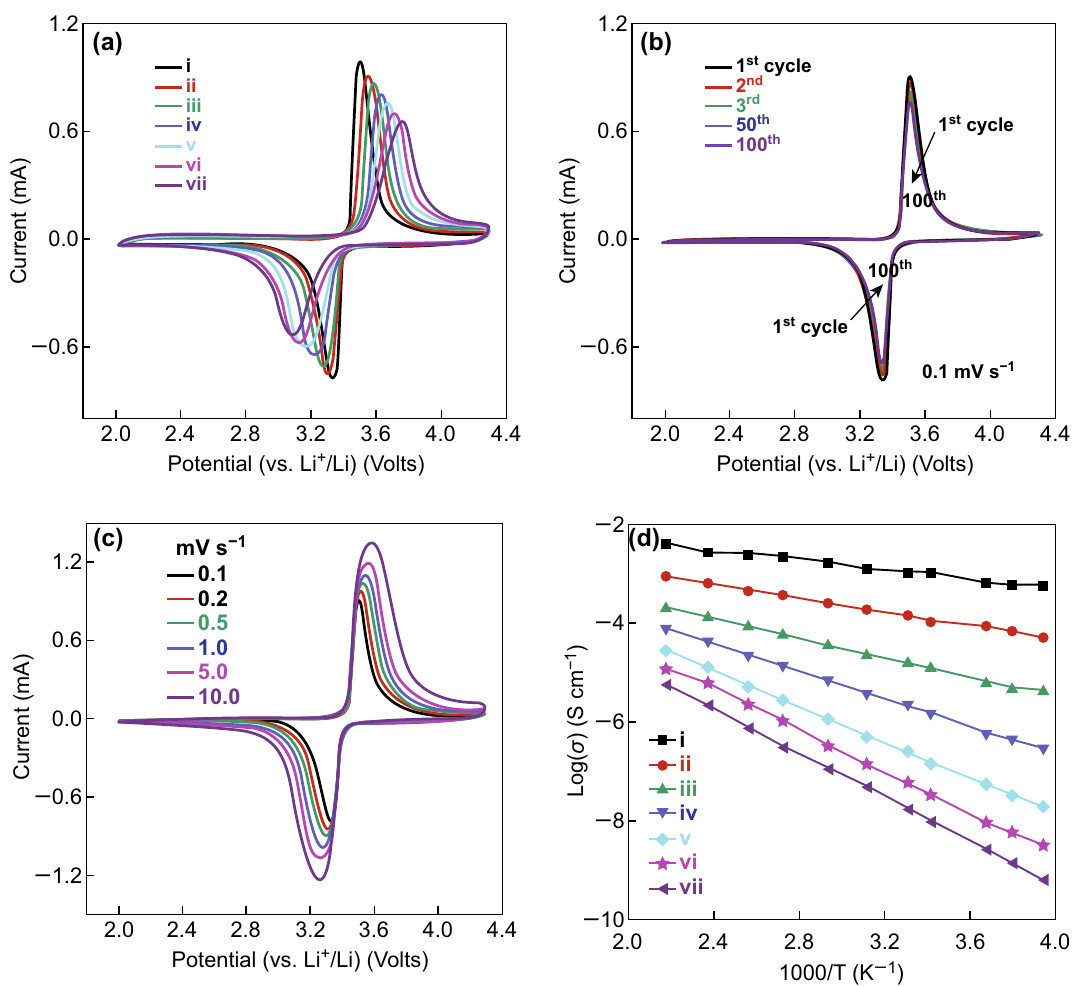
Fig. 3 a ‑ c Cyclic voltammograms (CVs) associated with a comprehensive investigation of the electrochemical performance of the power cath‑ ode VST‑(i–vii)@C hierarchy designated in the half‑cell LIB model (2032 coin‑type half‑cell tests with a Li counter electrode). a CV curves of different VST‑(i)@C, VST‑(ii)@C, VST‑(iii)@C, VST‑(iv)@C, VST‑(v)@C, VST‑(vi)@C, and VST‑(vii)@C cathodes. b CV curves of the VST‑(i)@C cathode at different cycle numbers that varied from 1 to 100 cycles at 0.1 mV s −1 in a half‑cell LIB and at different sweep rates (0.1, 0.2, 0.5, 1, 2, and 5 mV s −1 ). c All electrochemical measurements for the half‑cell VST‑(i)@C cathodes were operated within a voltage range